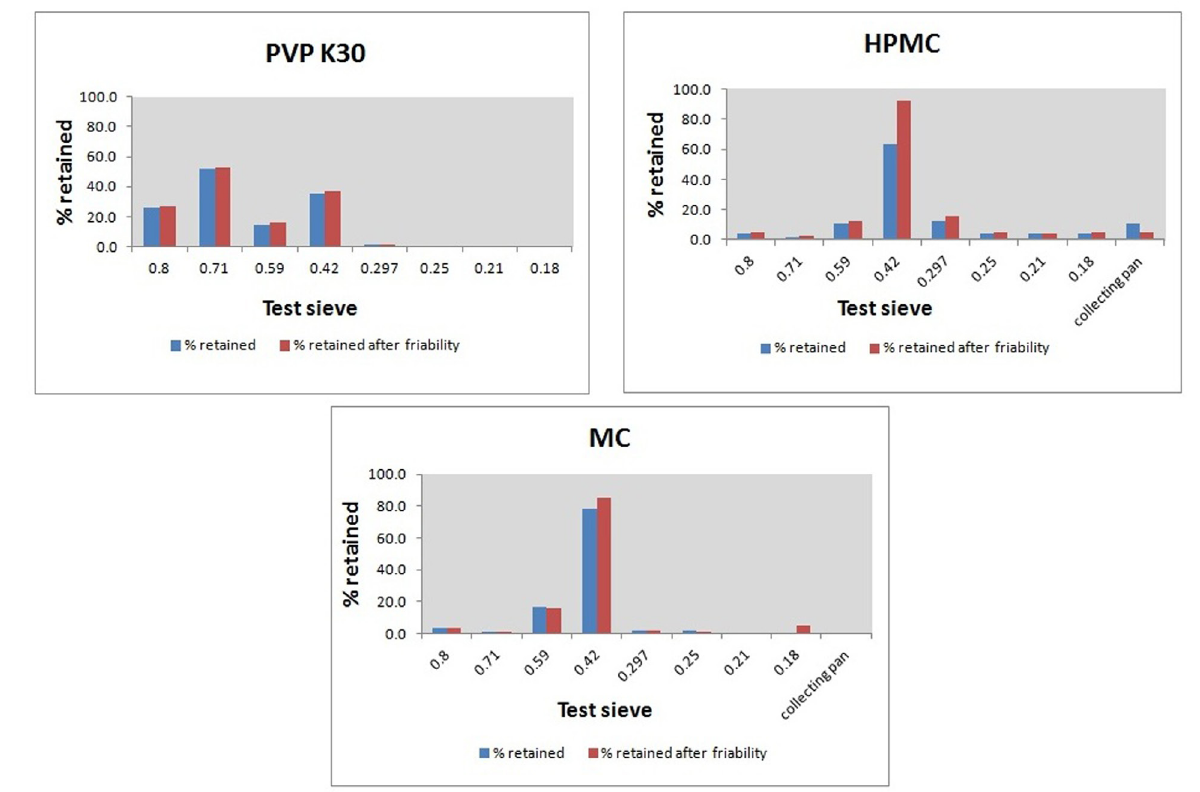
FIGURE 2 - Granulometric analysis of pellets 1 (PVP K30), 3 (HPMC) and 4 (MC) before and after the friability